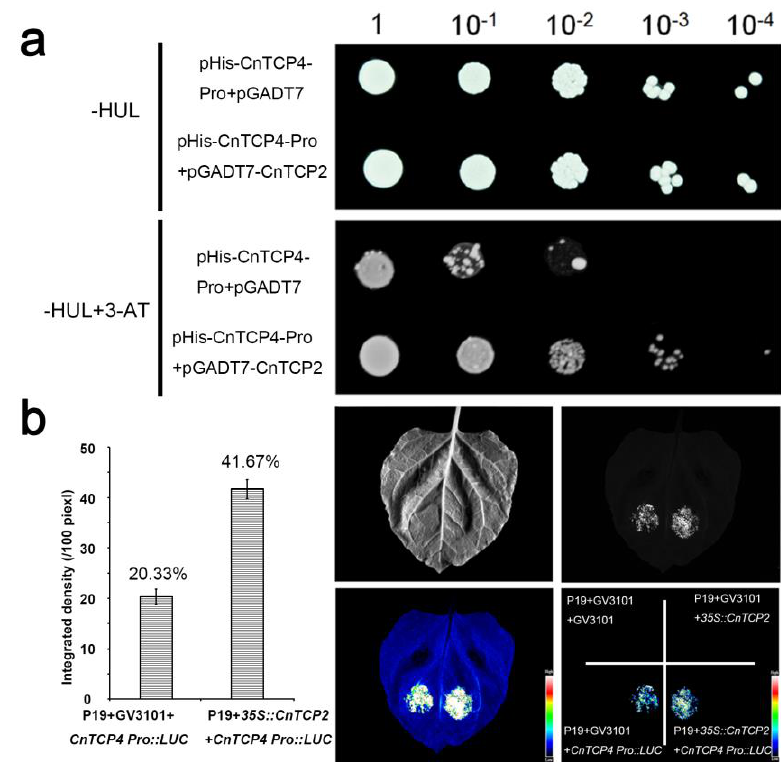
Figure 8. The CnTCP4 promoter interacted with CnTCP2. ( a ) Yeast one hybrid assay. Dilution analysis of the yeast transformants harboring CnTCP4-Pro and empty pGADT7 vector or CnTCP4-Pro and pGADT7-CnTCP2 on medium lacking His, Ura, and Leu with 3-AT or without it. -HUL: medium lacking His, Ura, and Leu; ( b ) CnTCP2 activated the CnTCP4 promoter in N. benthamiana leaves. P19 + GV3101 + GV3101: cultures of P19 plus GV3101 at a ratio of 1:2, P19 + GV3101 + 35S::CnTCP2: cultures of P19 plus GV3101 and p 35S::CnTCP2 at a ratio of 1:1:1, P19 + GV3101 + CnTCP4 Pro:LUC: cultures of P19 plus GV3101 and pCAMBIA1381Z-Luc- CnTCP4- Promoter at a ratio of 1:1:1, P19 + 35S::CnTCP2 + CnTCP4 Pro:LUC: cultures of P19 plus p 35S::CnTCP2 and pCAMBIA1381Z-Luc- CnTCP4- Promoter at a ratio of 1:1:1. Values shown as mean ± SE ( n = 10).